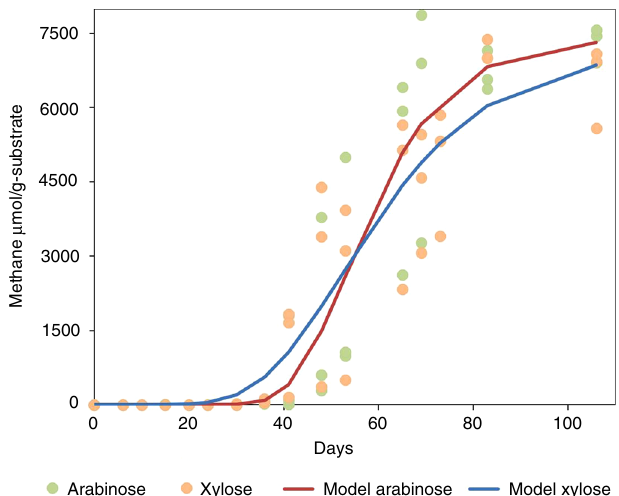
Fig. 3 Gompertz model and raw data points for the fi ve-carbon carbohydrates. The fi ve-carbon carbohydrates include arabinose and xylose. The values of the asymptote for methane Arabinose A = 7339 and xylose A = 7124, the parameters µ m, and λ are displayed in Table 1